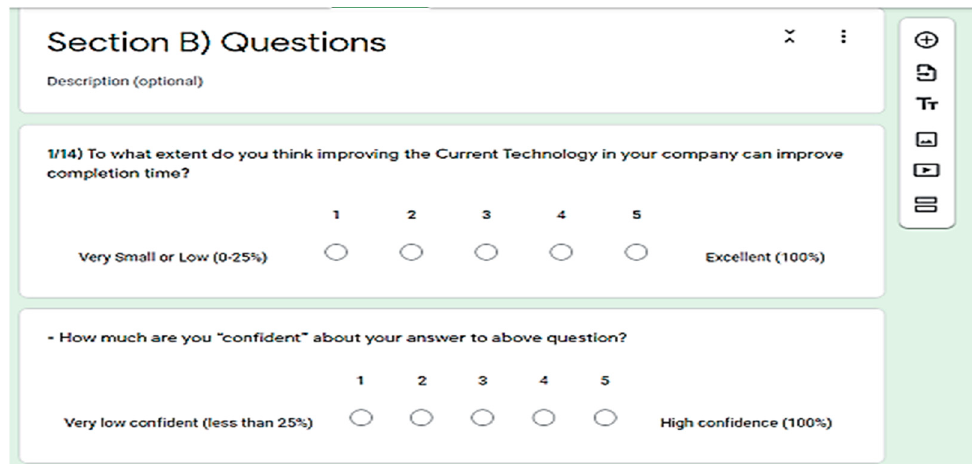
Figure 7. Asking confidence level for each question.